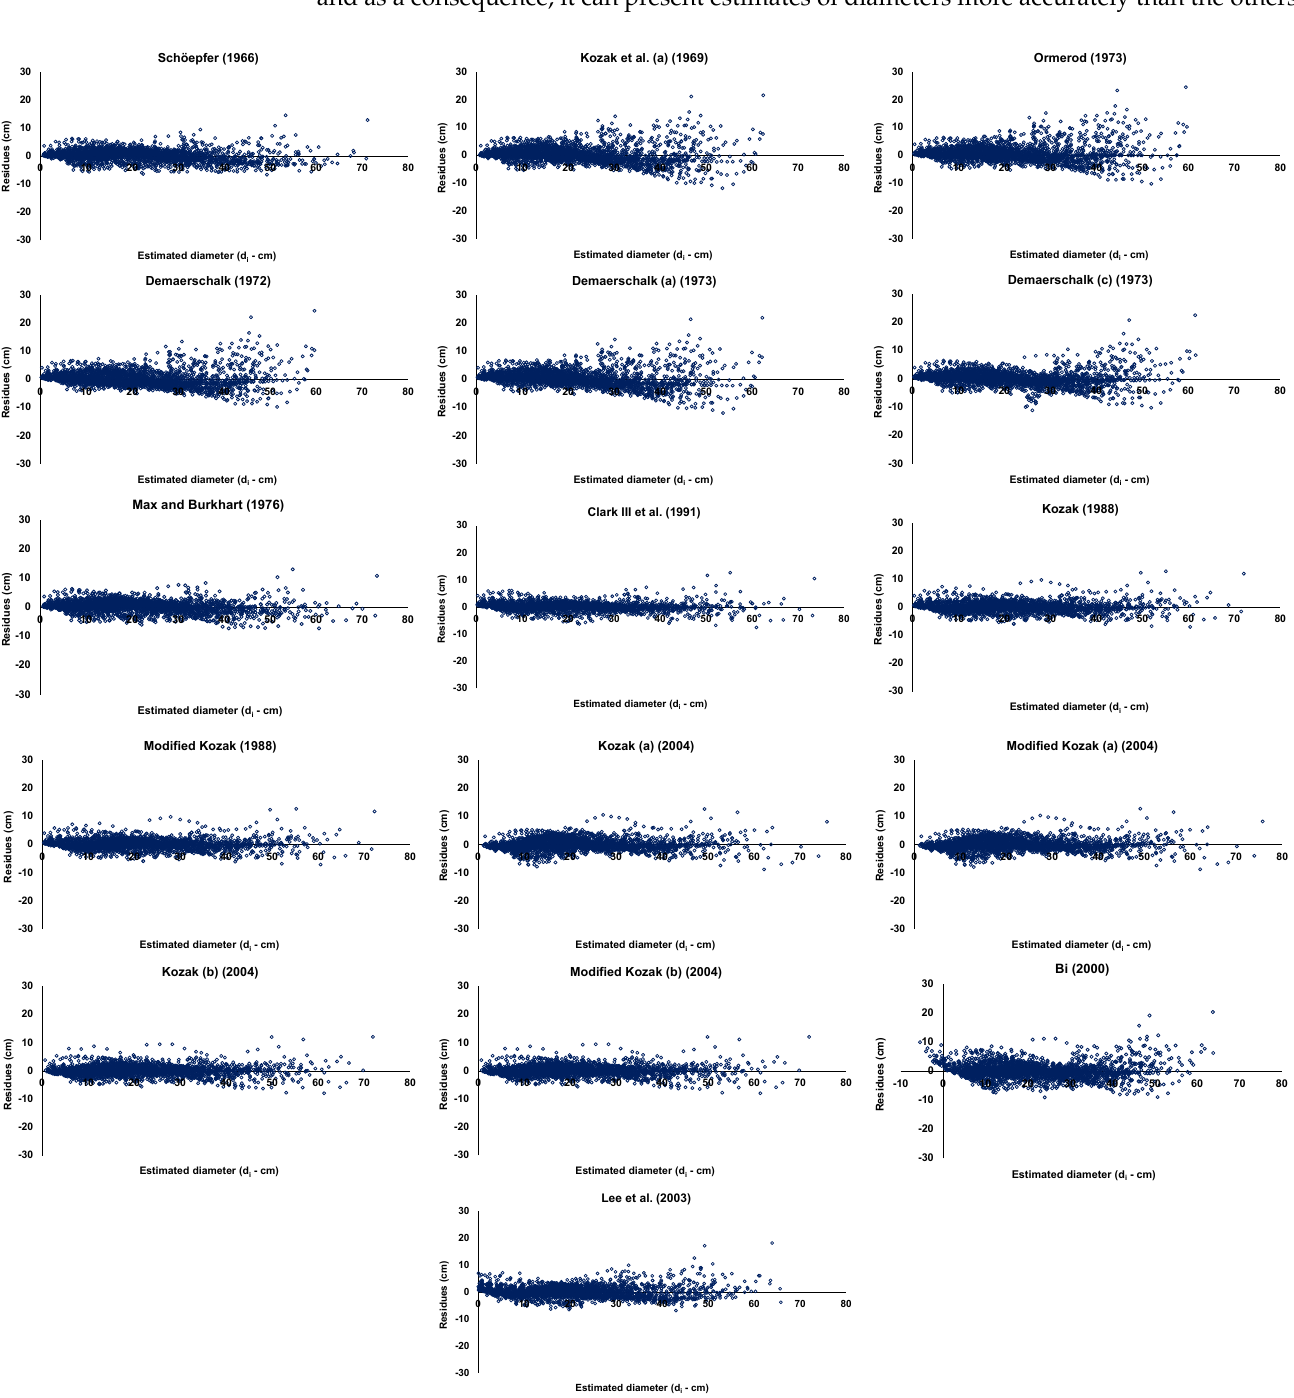
Figure 2. Residues from the estimates of diameters along the stem (d i ) using the taper equations without stratification of the Tectona grandis L.f. data., central-west region, Brazil [25,28,30–32,36,40,42–44,47].